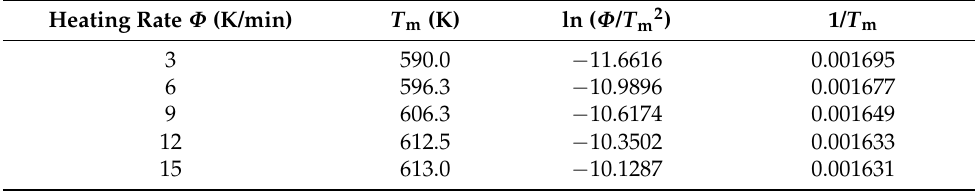
Table 2. Variations in T m , ln ( Φ / T m2 ), and 1/ T m , with heating rate Φ under 1.0 bar H 2 for hydrided Mg–5Ni.